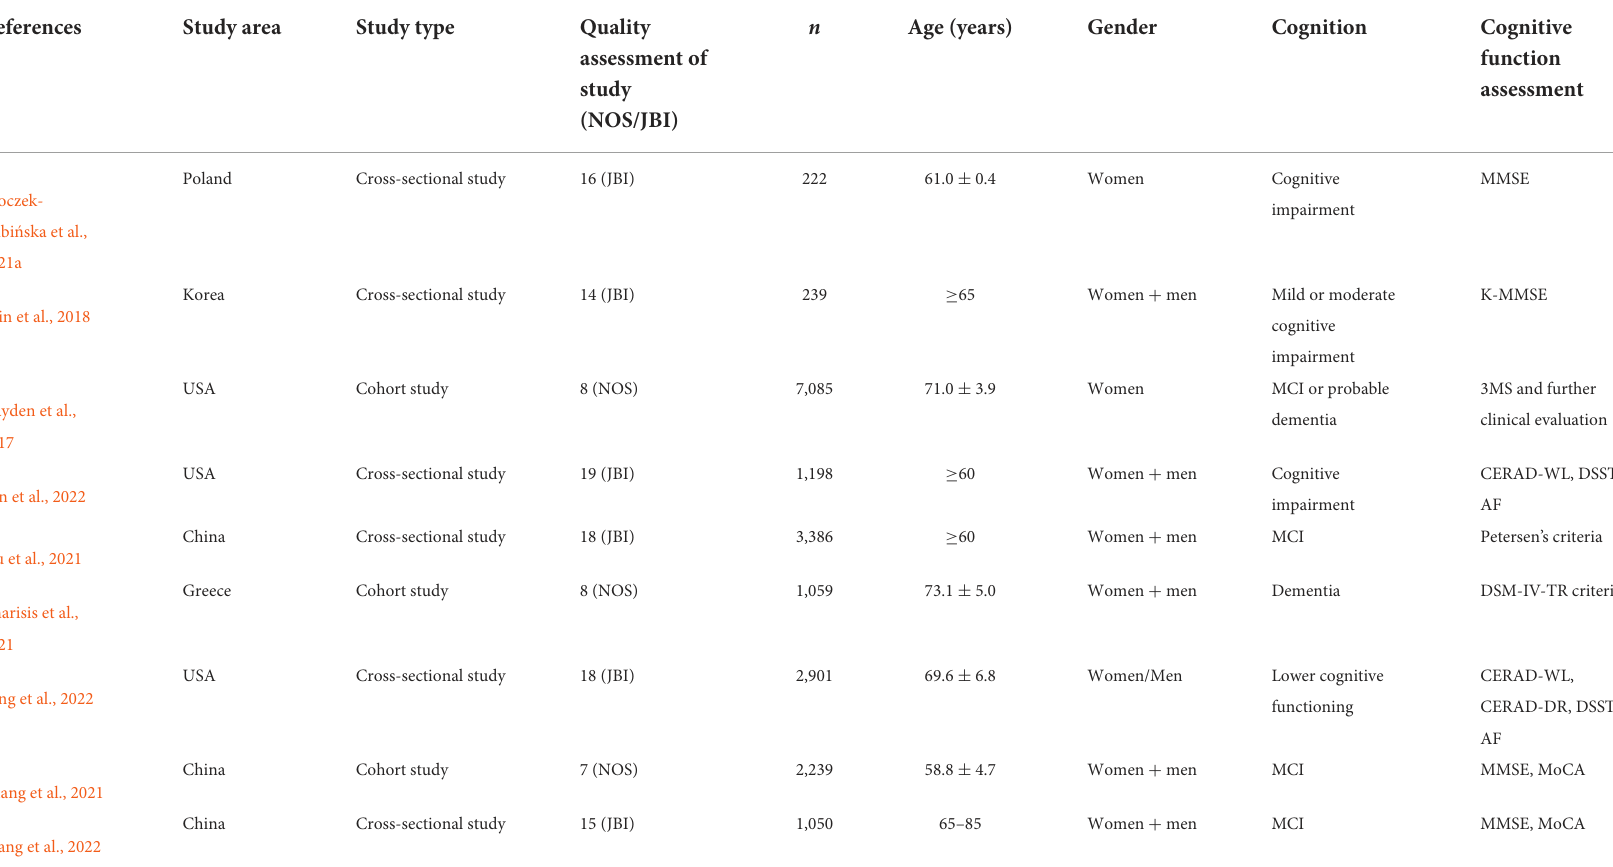
TABLE 1 Characteristics of studies evaluating the association between DII and cognition